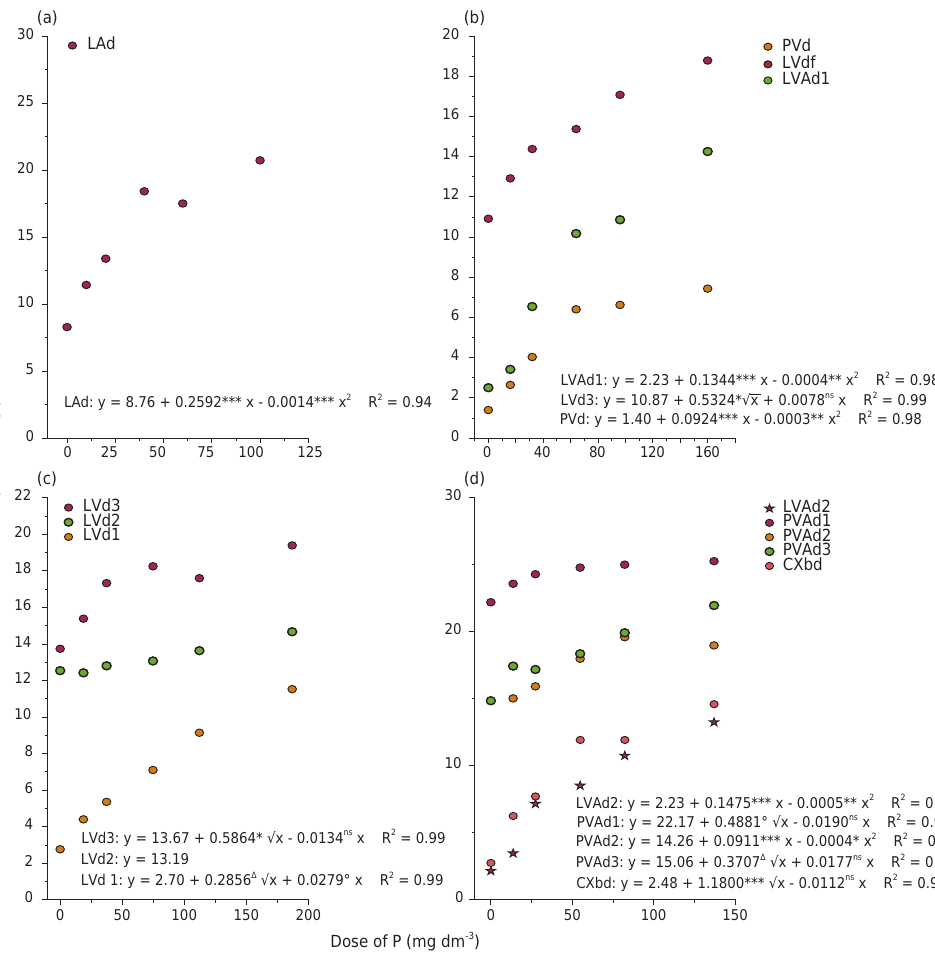
Figure 2. Equations for corn shoot dry matter yield (ŷ, g pot -1 ) according to the doses of P (x, mg dm -3 ) applied to each soil, and coefficient of determination (R²). The soil samples were grouped according to the doses of P applied: (a) 0 – 100 mg dm -3 ; (b) 0 - 160 mg dm -3 ; (c) 0 – 187 mg dm -3 ; (d) 0 – 137 mg dm -3 . ns, Δ, °, *, **, ***: not significant until 25 %, and significant at 25, 10, 5, 1, and 0.1 %,